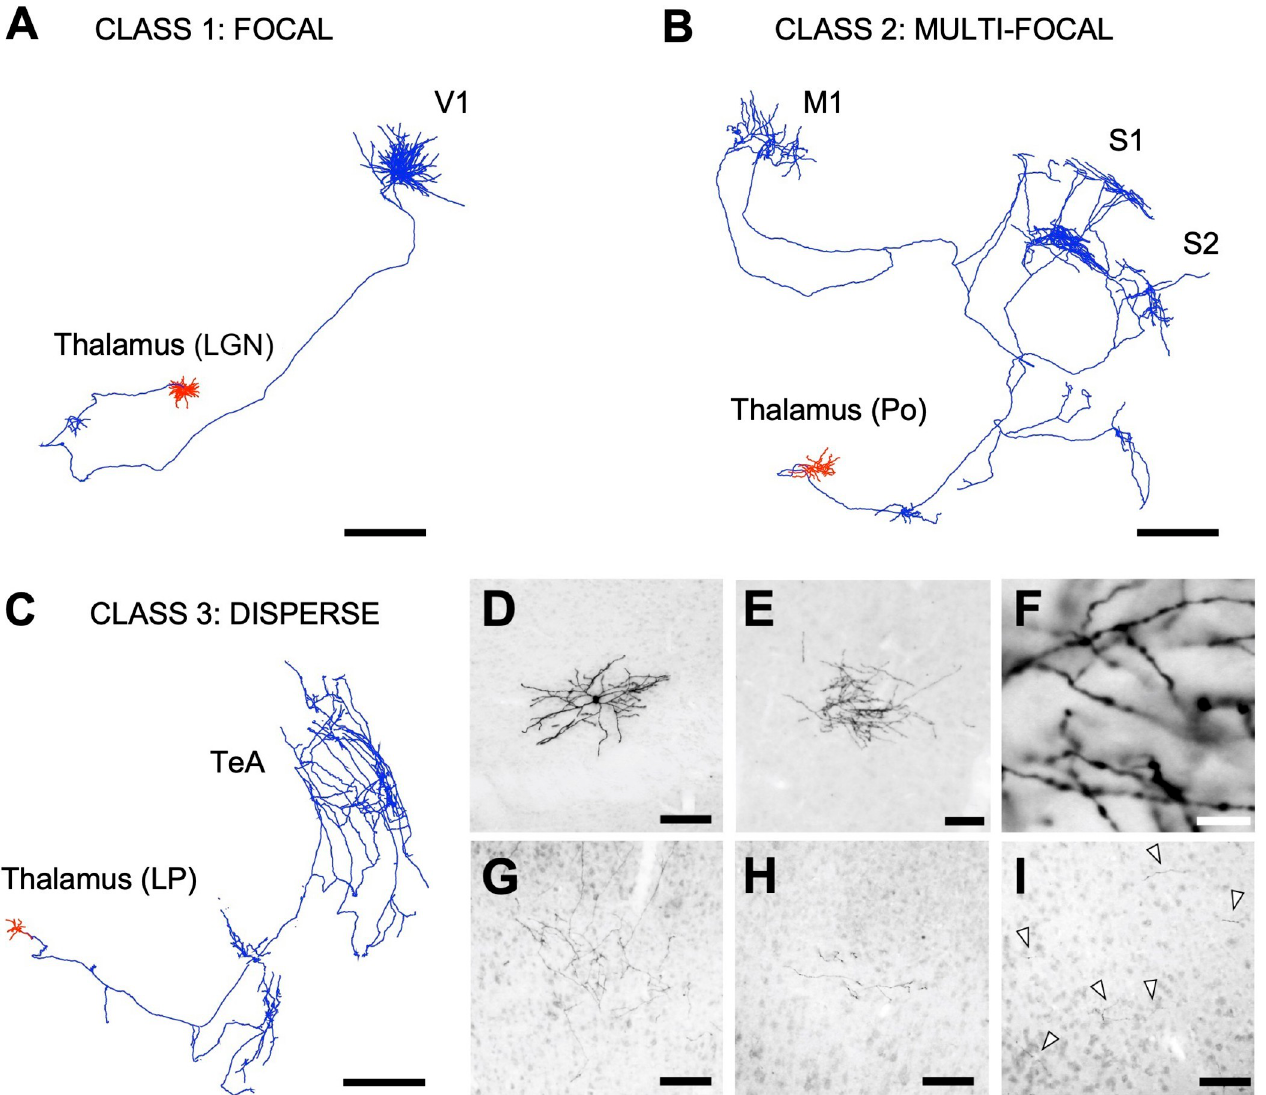
Fig 3. Reconstruction of the complete axonal (blue) and dendritic (red) trees of 3 individually-labelled thalamocortical neurons used for the practical implementation of the length estimation methods in the laboratory . A . Class 1 neuron from the lateral geniculate nucleus (LGN) arborizing focally in primary visual cortex (V1). B . Class 2 neuron from the posterior nucleus (Po) arborizing focally in 3 separate cortical areas: primary motor cortex (M1), primary somatosensory cortex (S1) and secondary somatosensory cortex (S2). C . Class 3 neuron from the lateral posterior nucleus (LP) arborizing over a large extension of the temporal association cortex (TeA). D-I . Brightfield microscope images of 50 mm thick coronal sections showing different parts of the labeled neurons after immunostaining for GFP and ABC-DAB-Nickel intensification. D . Cell body and dendrites of a Class 1 neuron. E . Axonal arborization in the cortex of a Class 1 neuron. F . High—magnification details of the axonal branches shown in E. G-H . Axonal arborizations of the Class 2 neuron in the motor cortex (G) and the primary somatosensory cortex (H). I . Axonal arborization in the temporal cortex of the Class 3 neuron. Note the sparse distribution of the axonal fragments (Arrowheads). Scale bars: A-C, 500 μ m; D, E, G, H, I, 100 μ m; F, 10 μ m.